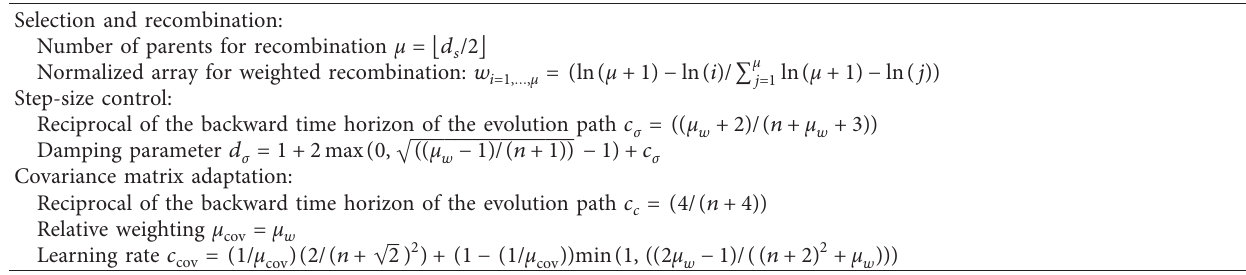
Figure 13: The performance criterion satisfaction probabilities for the obtained hyperboxes. (a) GHZ method, (b) SA-DIRECT method, and (c) d CMA-ES-DIRECT method. Table 9: Default strategy parameters values.